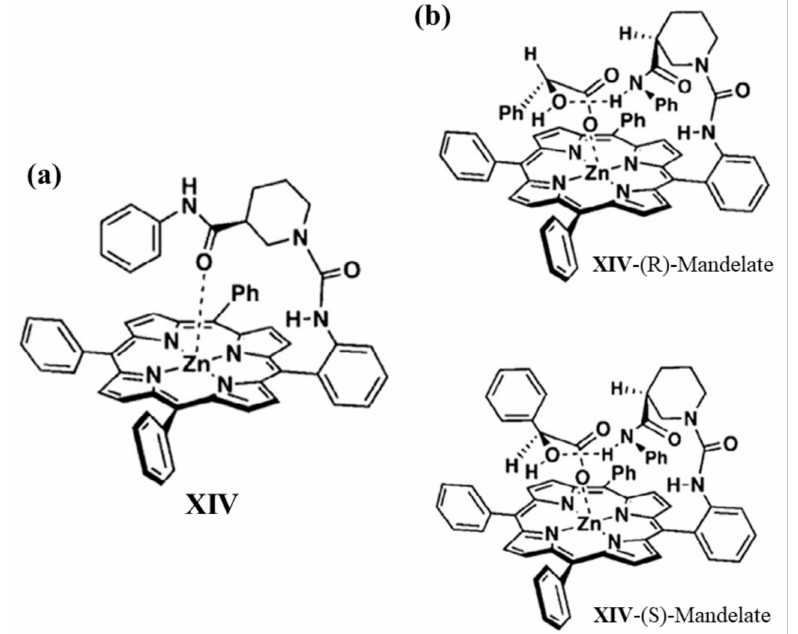
Figure 11. ( a ) Molecular structure of the chiral Zn(II)-porphyrin derivate XIV obtained by Starnes et al.; ( b ) Suggested complexes and relative interactions of XIV -(R)-mandelate (top) and XIV -(S)- mandelate (bottom). Adapted with permission from reference [69]; published by American Chemical Society